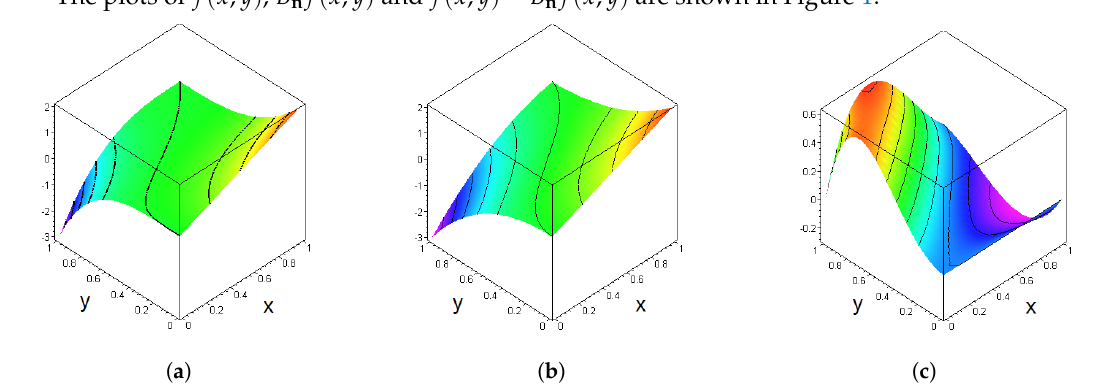
. ( b ) Plot of B n f x , y p q